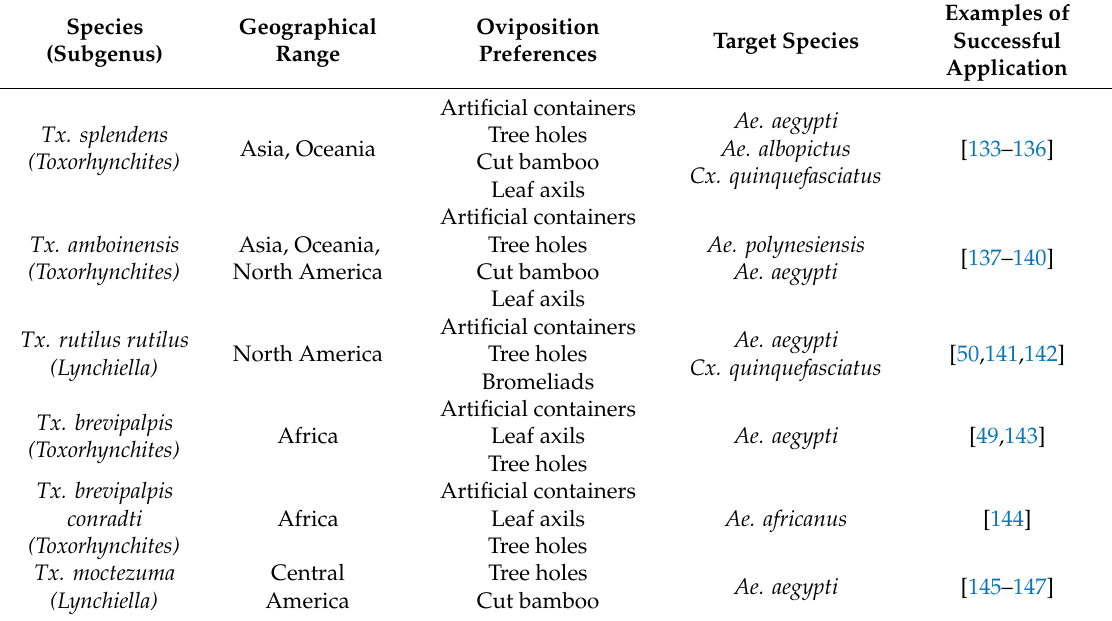
Table 1. Toxorhynchites species used successfully as biological control